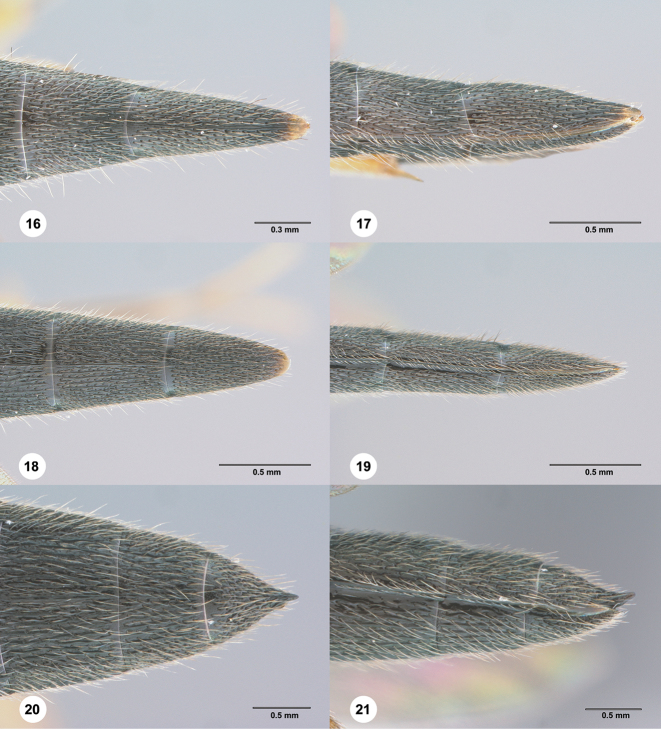
16–17Chromoteleialongitarsis Kieffer, female (OSUC584896). 16 Apical metasoma, dorsal view 17 Apical metasoma, lateral view 18–19Chromoteleiadepilis sp. n., female, holotype (OSUC577436)) 18 Apical metasoma, dorsal view 19 Apical metasoma, lateral view 20–21Chromoteleiabidens sp. n., female, holotype (OSUC577455) 20 Apical metasoma, dorsal view 21 Apical metasoma, lateral view.